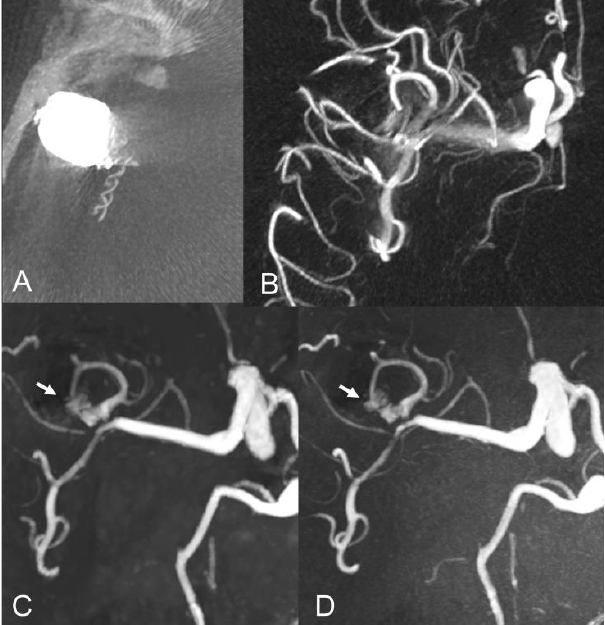
Figure 3. Baseline axial CT image ( A ) and vaso-CT ( B ) after stent-assisted coiling of a middle cere- 193 bral artery aneurysm. Follow-up axial MIP images of CS TOF ( C ) and PI TOF ( D ) showing residual flow (arrows) between the coils (class IIIb).